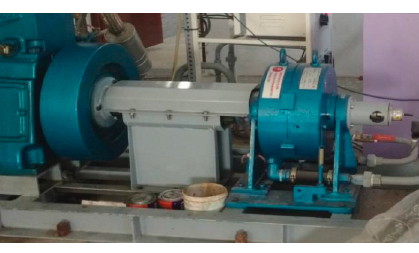
Figure 2: Loading unit.